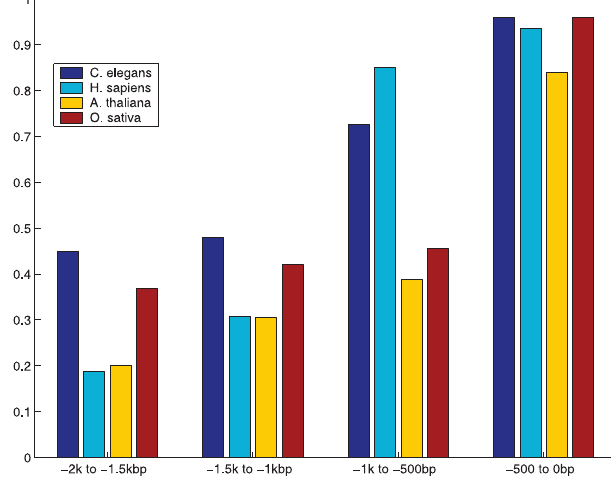
Figure 1. The Distribution of the Distances between Putative Promoters and MicroRNA Hairpins The horizontal axis shows the positions of putative promoters with respect to the corresponding microRNA hairpins and the vertical axis shows the percentage of microRNA genes that have putative promoters at the specified positions.